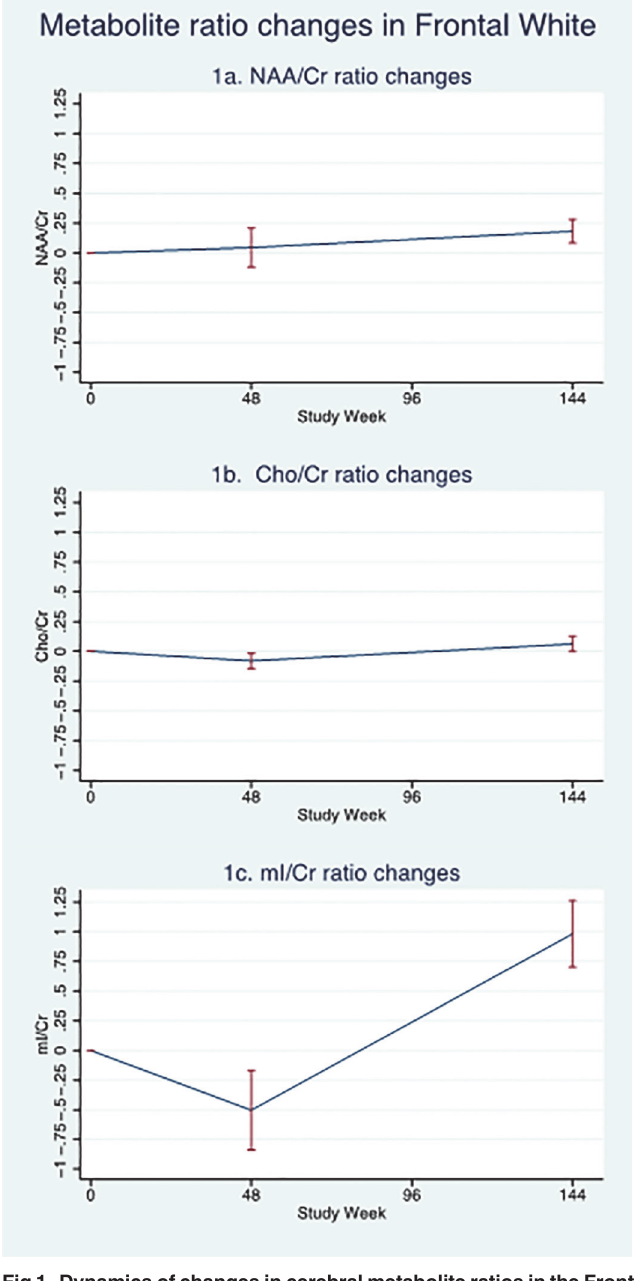
Fig 1. Dynamics of changes in cerebral metabolite ratios in the Frontal White matter over 3 years. Fig. 1A: Mean changes in N-acetyl-aspartate/Creatine ratio; Fig. 1B: Mean changes in Choline/Creatine ratio and Fig. 1C: Mean changes in myo-Inositol/Creatine ratio (error bars represent 1 standard error).